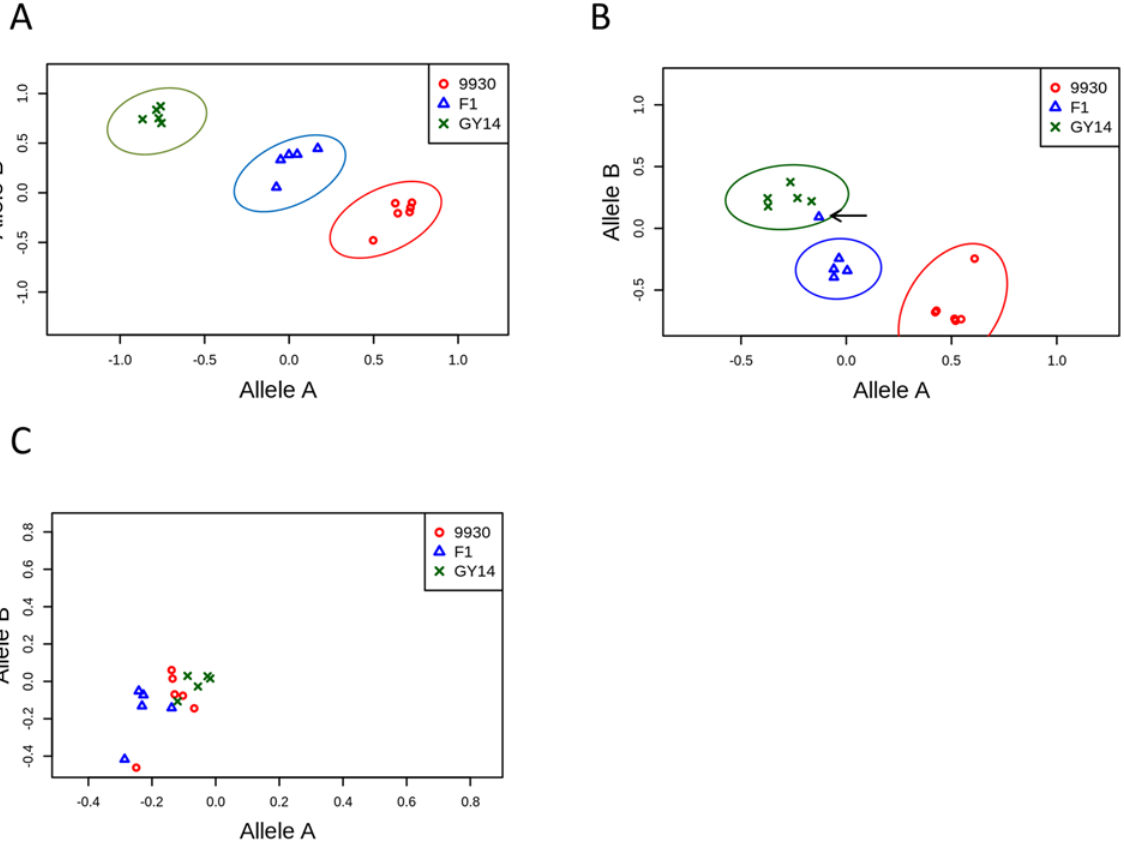
Fig 1. Example of three types of training sets. Hybridization signals of ‘ GY14 ’ (green X), ‘ 9930 ’ (red circles), and their F 1 (blue triangles) were plotted as scatter plots of allele X signals against allele Y signals. (A) Three distinct clusters were generated. This was considered a probe set for a SNP with a good training set. (B) Three distinct clusters were generated, one of which was clustered incorrectly. This was also considered a good training set. (C) No distinct cluster was generated. These SNP probe sets were not included in the genotype call analysis.